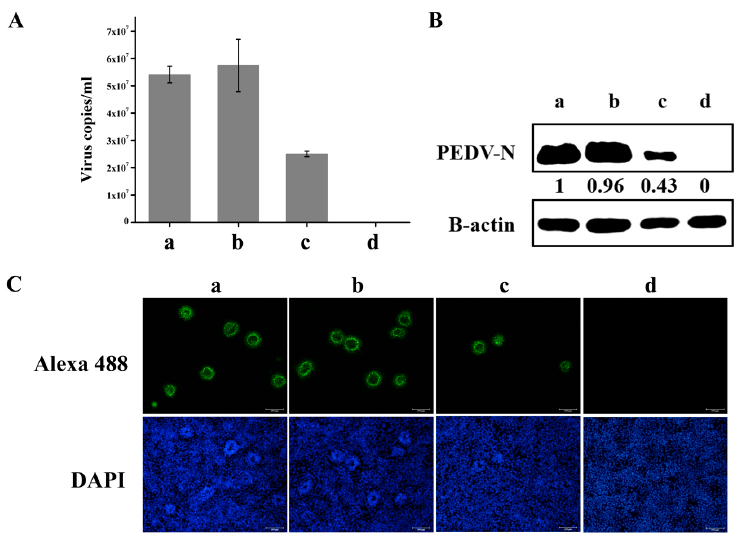
Figure 5. Knockdown of hnRNP A1 expression inhibits YN144 replication. CCL-81 cells were transfected without siRNA (a) or with NC (b) or siRNA-1 (c). At 60 hpt, cells were infected with YN144 Strain at a moi of 0.001 or mock infected (d). Virus suspensions were harvested at 12 hpi to calculate the virus titer by real-time RT-PCR. The virus copies per mL suspension was calculated ( A ). Cells were harvested at 12 hpi to analyze the expression of PEDV N protein by Western blot ( B ) and the numbers of cells infected with PEDV by IFA (Original magnification 100 × ) ( C ). PEDV N protein levels were quantified by measuring band intensities and normalized with respect to the amount of β -actin. Data are shown as means ± the standard errors of the mean (SEM) of at least three independent experiments, with the error bars representing the standard